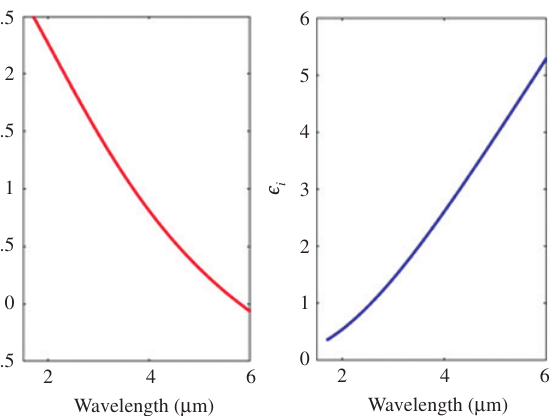
Figure 3: The permittivity of the ISO thin film.